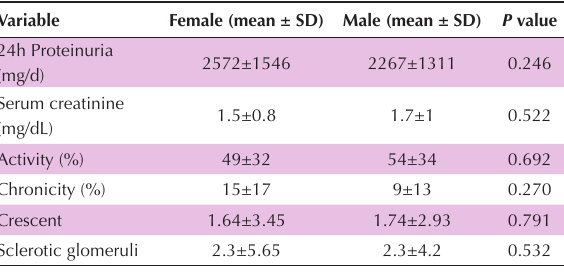
Table 6. Assessments of 24-h proteinuria, serum creatinine, disease activity and chronicity by gender Variable Female (mean ± SD) Male (mean ± SD) P value 24h Proteinuria (mg/d)